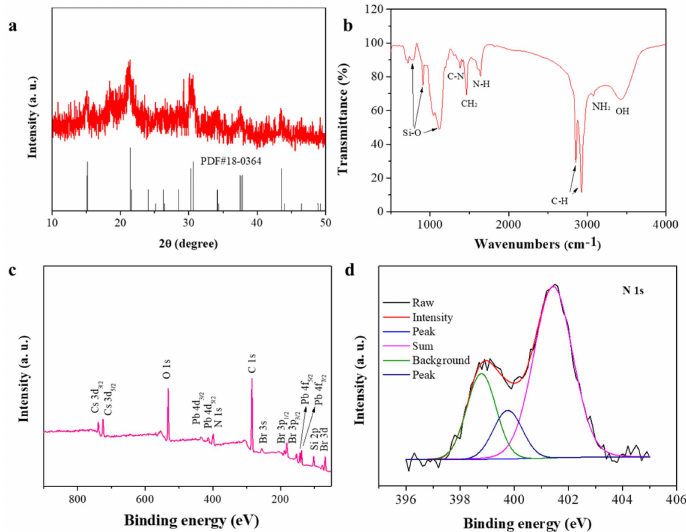
Figure 2. ( a , b ) XRD pattern and FT-IR spectra of CsPbBr 3 @SiO 2 PNCCs; ( c , d ) XPS spectra of CsPbBr 3 @SiO 2 PNCCs and corresponding high − resolution N1s peak. The structure and composition of CsPbBr 3 @SiO 2 PNCCs were further characterized by TEM, HRTEM and EDX. As shown in Figure 3, the TEM image of CsPbBr 3 @SiO 2 PNCCs shows uniform CsPbBr 3 PNCs embedded in SiO 2 since the surface of SiO 2 contains many N groups that act as anchor sites for the nucleation and growth of CsPbBr 3 PNCs. The larger size distribution of CsPbBr 3 PNCs is mainly caused by different microenvironments, as shown in Figure 3a. The content of each element in CsPbBr 3 @SiO 2 PNCCs, as listed in Figure 3b, was found to be Cs 12.381%, Pb 5.840%, Br 23.050%, Si 18.613% and O 40.114% using EDX.